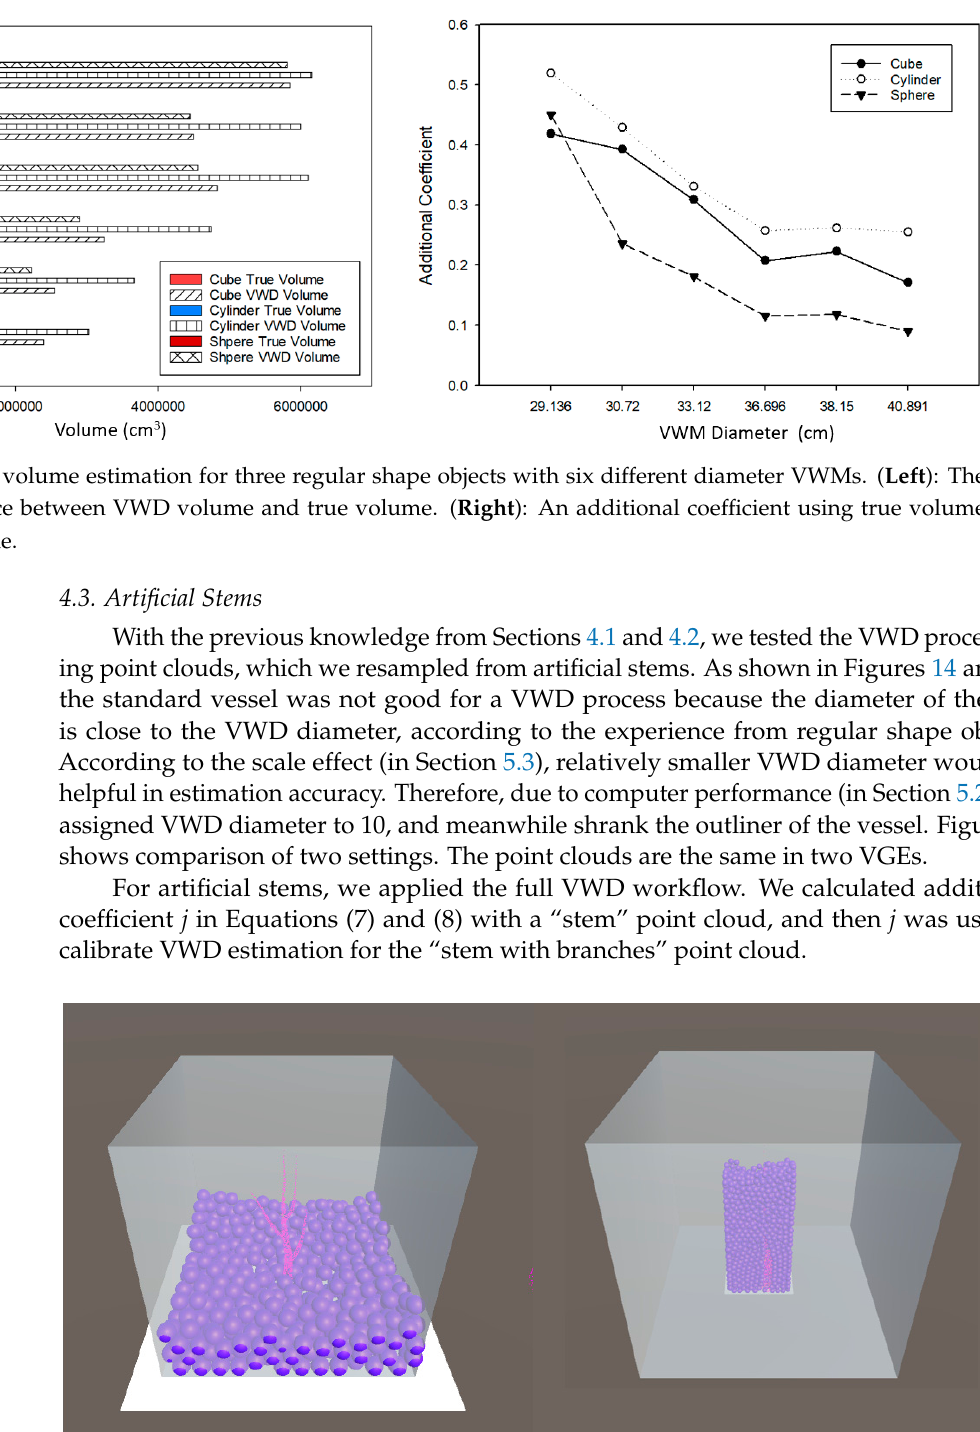
Figure 15. Scale effect of VWMs. ( Left ): VWMs (diameter = 29.136 cm) collide with the artificial point cloud (bottom view); ( Right ): VWMs (diameter = 10 cm) collide with the same point cloud (front view). Table 3 is the experiment record. The standard deviation maintained a similar per- formance for VWMs filling compared to fillings Sections 4.1 and 4.2. From the “stem” point cloud, we determined the empirical 𝑗 value, 0.573. Then, we used this coefficient to calibrate the volume for the “stem with branches” point cloud. The VWD volume was determined as 29,636 cm 3 (overestimation at 6.0%), where the true volume is 27,946 cm 3 and the QSM derived volume is 26,155 cm 3 (Table 2, mean value, repeated 11 times, un- derestimation at 6.9%). It was found that the stem volume obtained by the VWD method was greater than the true value. Meanwhile, the stem volume obtained by the QSM method was always smaller than the true value. This was not a coincidence and was not related to a specific data set. It reflected the difference between the two methods at the algorithmic level. A mathematically based method, e.g., QSM, usually calculated the av- erage value for some reason. In this case, the position of a cylinder surface was used to generate in the middle layer of the point cloud by QSM. As a result, there was a high chance that the volume between the contour of the point cloud and the intermediate layers would be lost. Therefore, the QSM intended to make an underestimation compared to the true volume. On the contrary, the VWD used external detection for point clouds. Due to the limitations of computers, it was likely that there were always undetected gaps. There- fore, the VWD intended to include the additional volume where the gaps belonged.